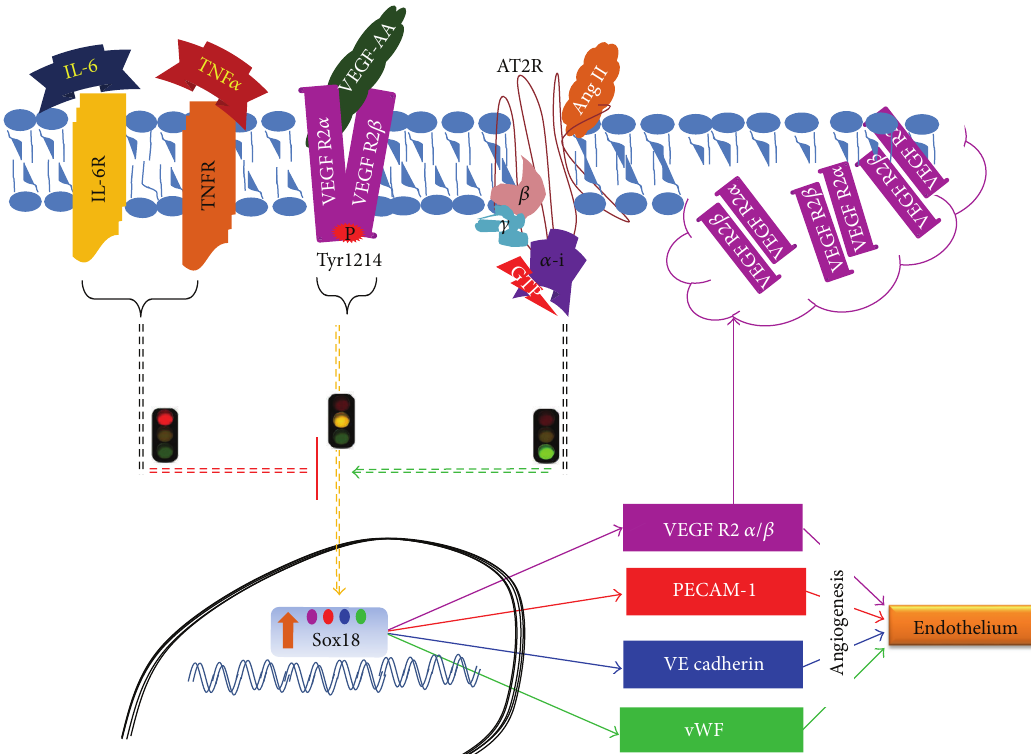
Figure 7: Schematic diagram showing interactions among receptors and signaling pathways during the differentiation of BM-MSCs into